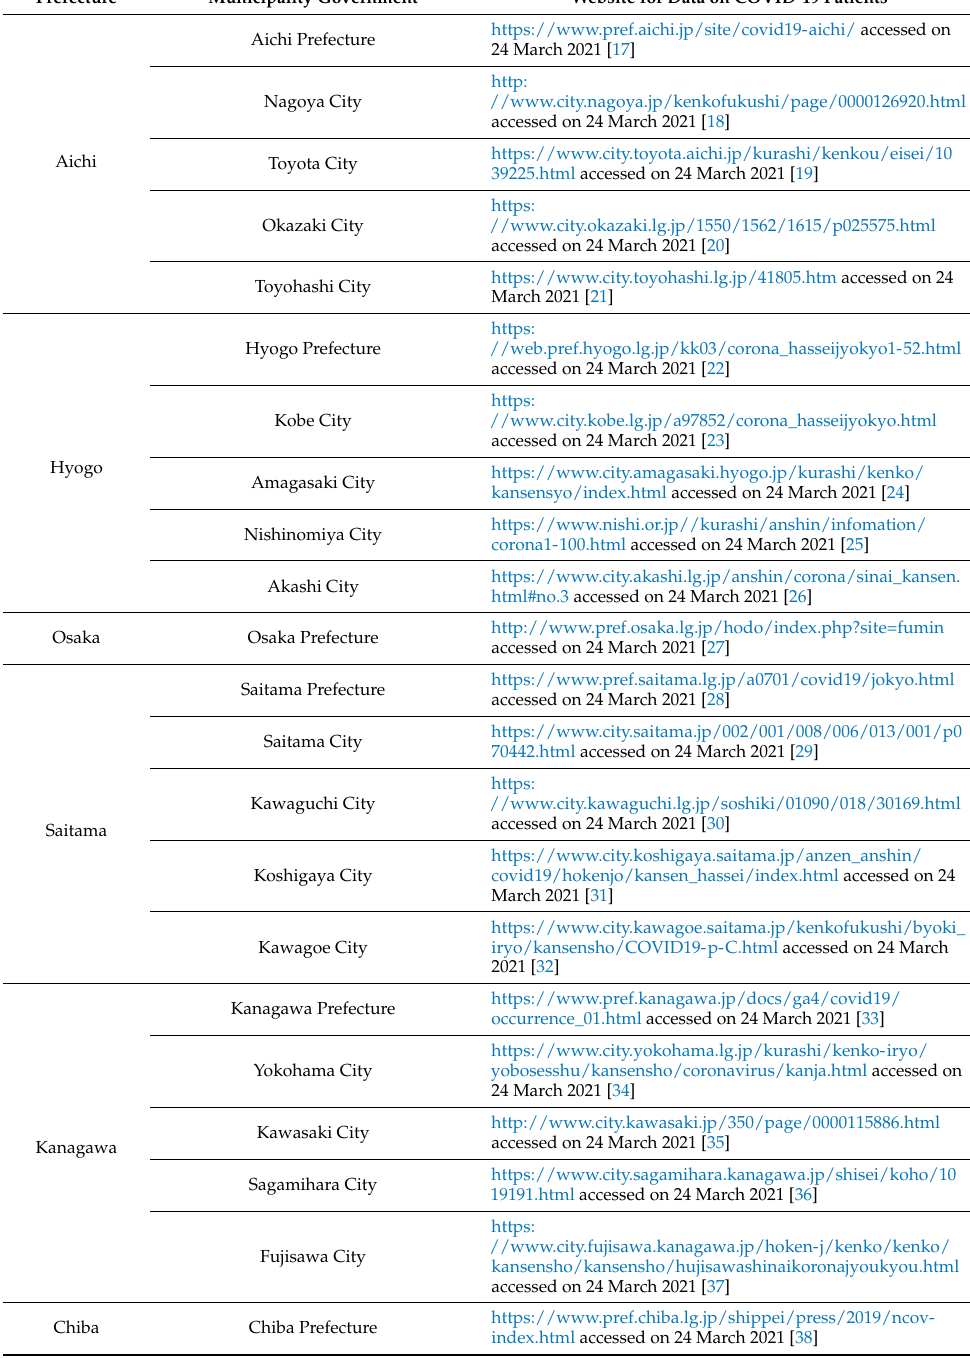
Table A1. Government websites for data collection on COVID-19